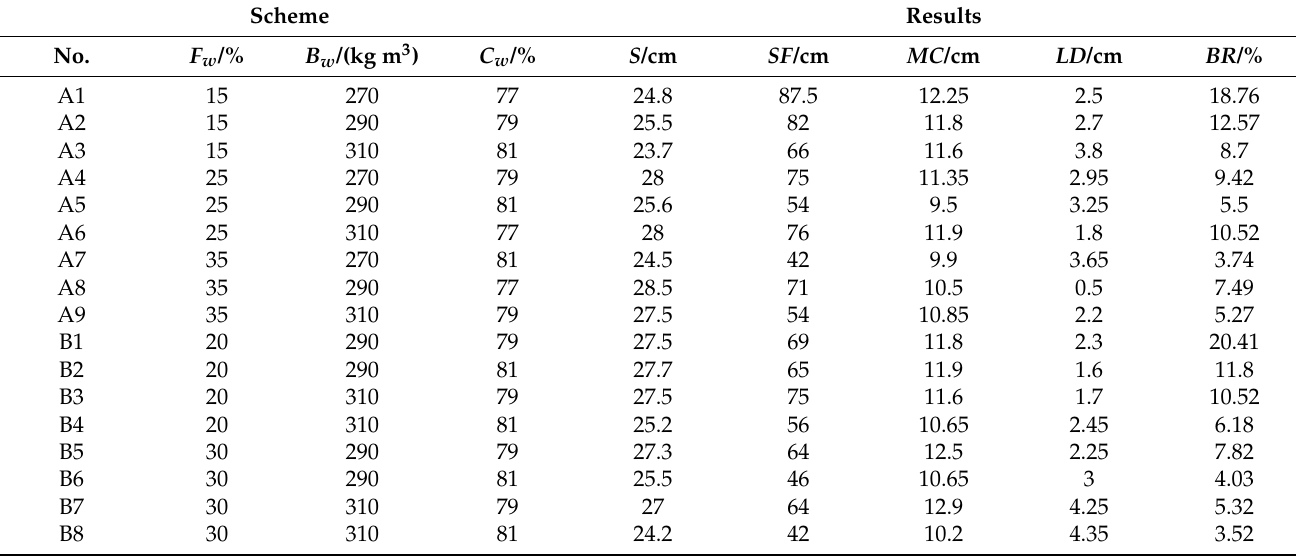
Table 3. Scheme and results of the slurry flow property tests.